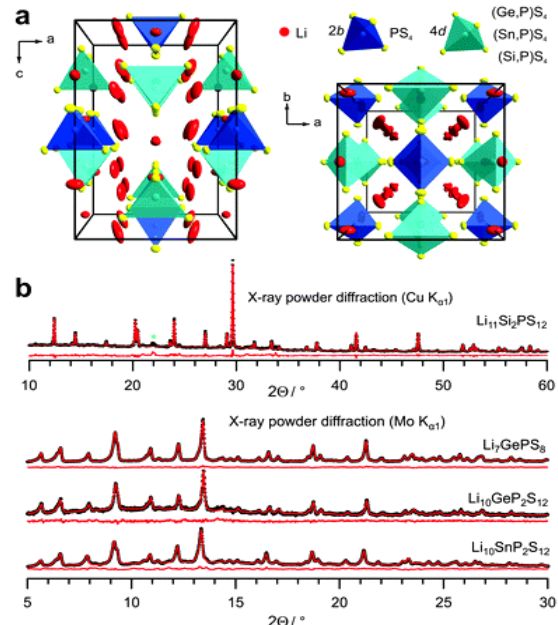
Figure 17. ( a ) Crystal structure of tetragonal Li 10 GeP 2 S 12 (LGPS) obtained using single-crystal X-ray diffraction. ( b ) X-ray powder diffraction patterns and Rietveld refinements of Li 11 Si 2 PS 12 and Li 10 SnP 2 S 12 compared with those previously reported for Li 10 GeP 2 S 12 and Li 7 GePS 8 . The side phase was marked with a green asterisk. Reproduced with permission from [270]. Copyright 2014 Royal Society of Chemistry.